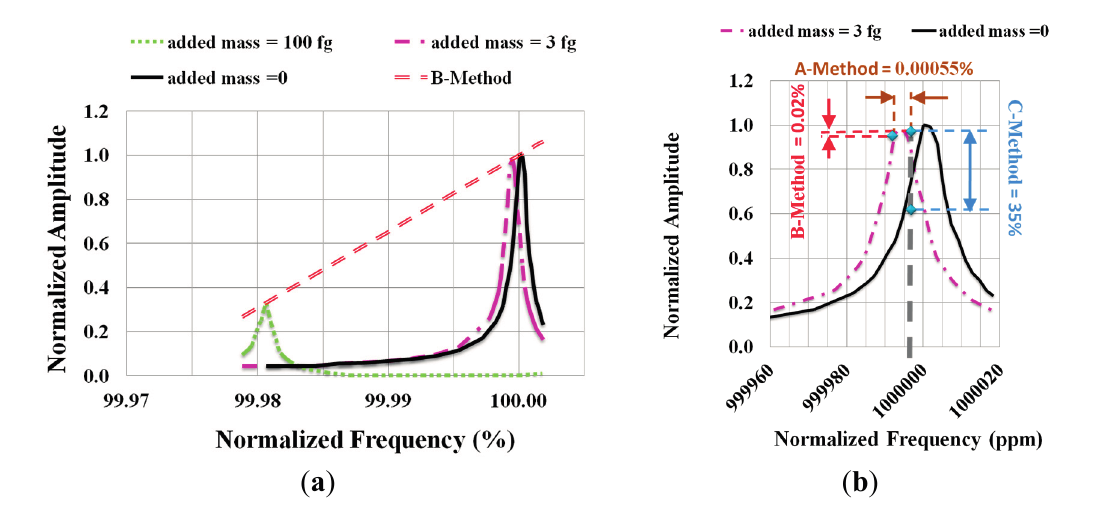
Figure 4. ( a ) Amplitude with and without added mass vs resonance frequency; ( b ) Zoom on the overlap shown in (a).